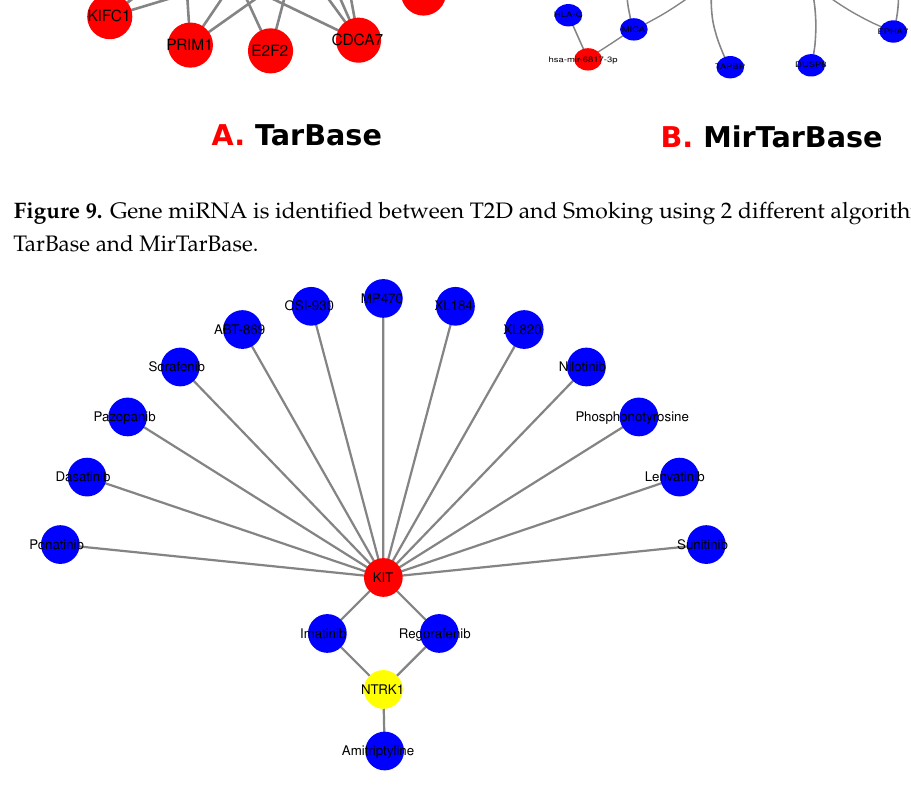
Figure 10. The figure shows the Protein–Drug Interaction between T2D and smoking using Protein– Drug Interaction